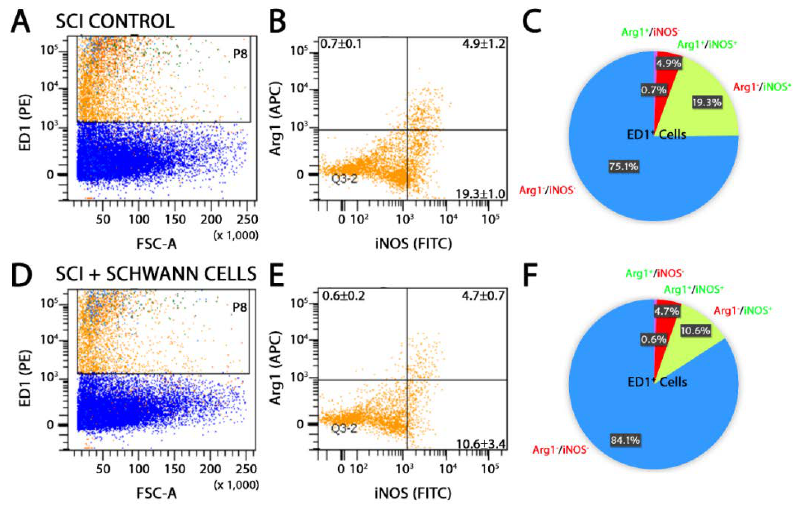
Figure 3. CD68 immune cells with a pro-inflammatory Arg1 − iNOS + phenotype after SCI are reduced by SC transplantation. Representative images of flow cytometry analysis and pie charts of CD68 population dynamics at 14 days post-injury (7 days post-transplantation) reveal that CD68 immune cells with a pro-inflammatory Arg1 − iNOS + phenotype after SCI ( A – C ) are reduced by the intraspinal transplantation of SCs ( D – F ). Results are expressed as mean ± SD. For panels ( A , D ), the orange dots represent the ED1 population that were gated based on their forward and side scatter from the total events (blue) that were acquired. The orange dots in the different quadrants of ( B , E ) represent the ED1 population that was positive for either Arg1 (top left quadrant) or iNOS (bottom right quadrant) or double positive for both markers (top right quadrant).